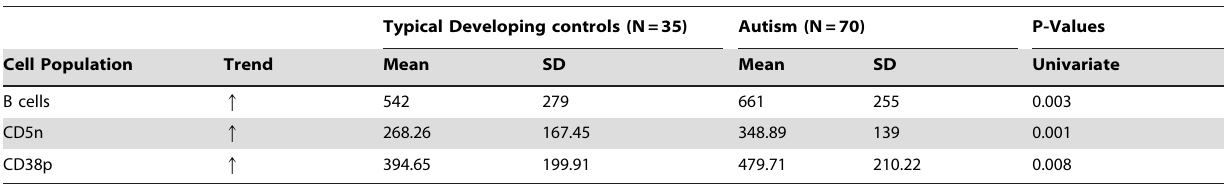
Table 6. Comparison of B cell subsets.